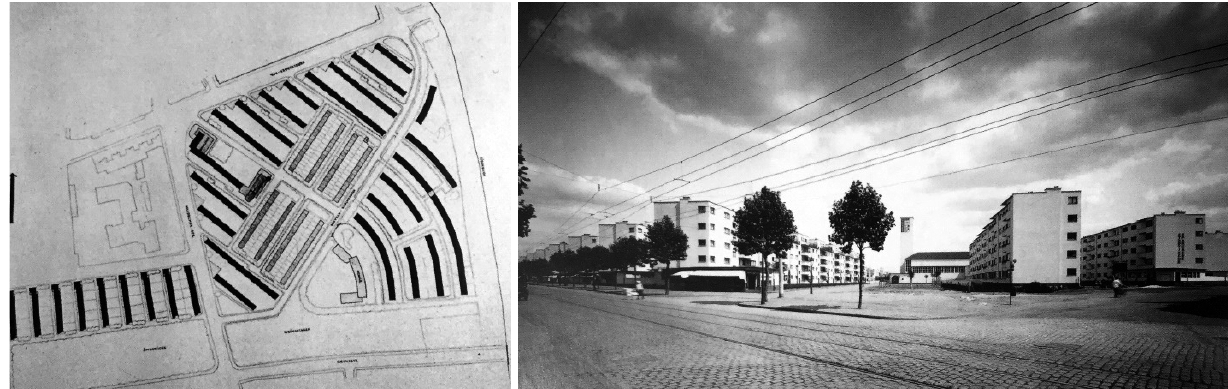
Figure 16. From left to right: W. Riphahn, Cologne-Buchforst, Siedlung Weisse Stadt , 1929–1930 (Fries, 1930); Heildelberger Straße corner (“Heildelberger Straße corner”,